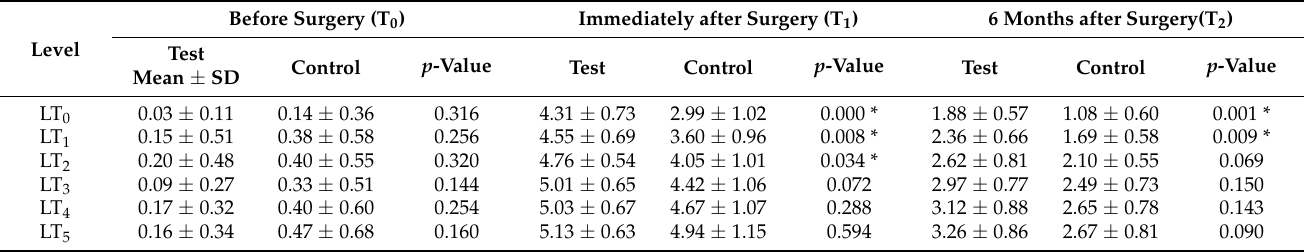
Table 2. Results of the labial thickness of the hard tissue at different vertical levels (mm).